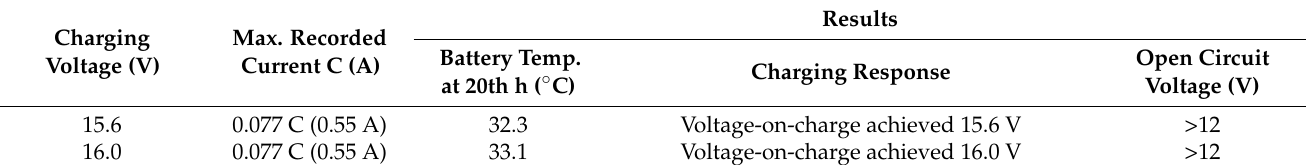
Table 5. Charging results for the recovered batteries charged at high charging voltages.